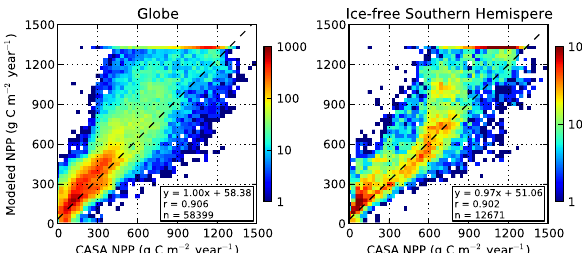
Fig. 4. Two-dimensional histograms of NPP derived from the sim- ple MAP and MAT-dependent variables versus CASA NPP for all terrestrial 0.5 ◦ grid cells globally (left panel) and the Southern Hemisphere (right panel). The color scale indicates the number of 0.5 ◦ grid cells corresponding to NPP bins. Least squares linear re- gression lines are shown in black. The modelled emissions were capped at 1300gCm − 2 yr − 1